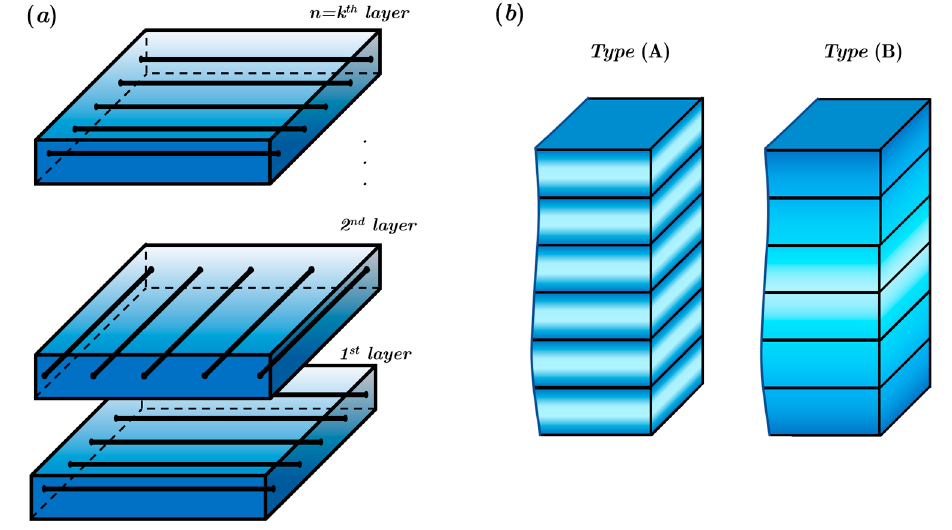
Figure 2. The geometry of multilayer structure ( a ) and their types ( b ).